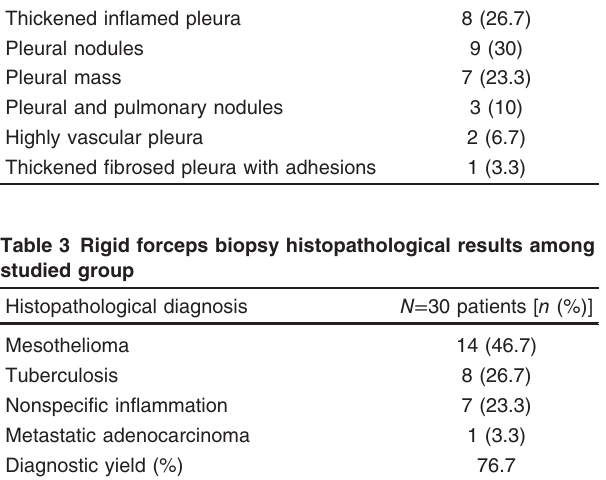
Table 2 Thoracoscopic findings among studied group Thoracoscopic finding